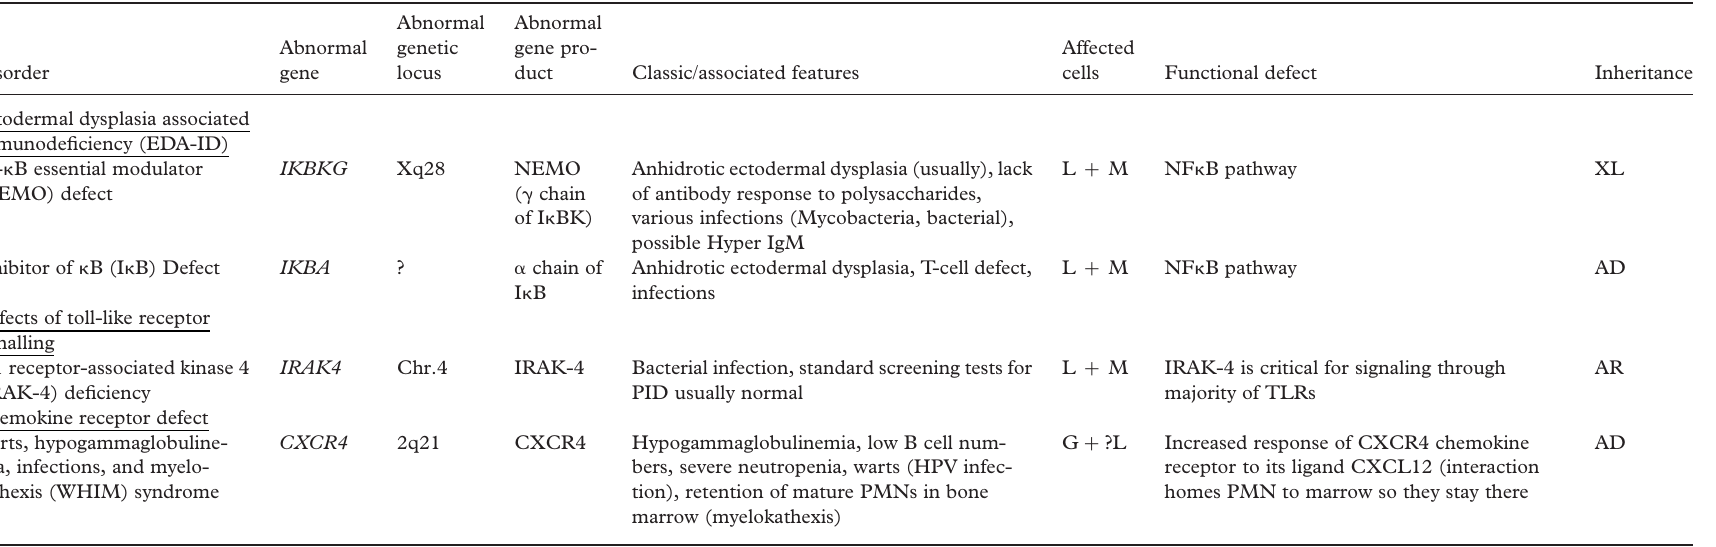
Table IV. Defects of innate